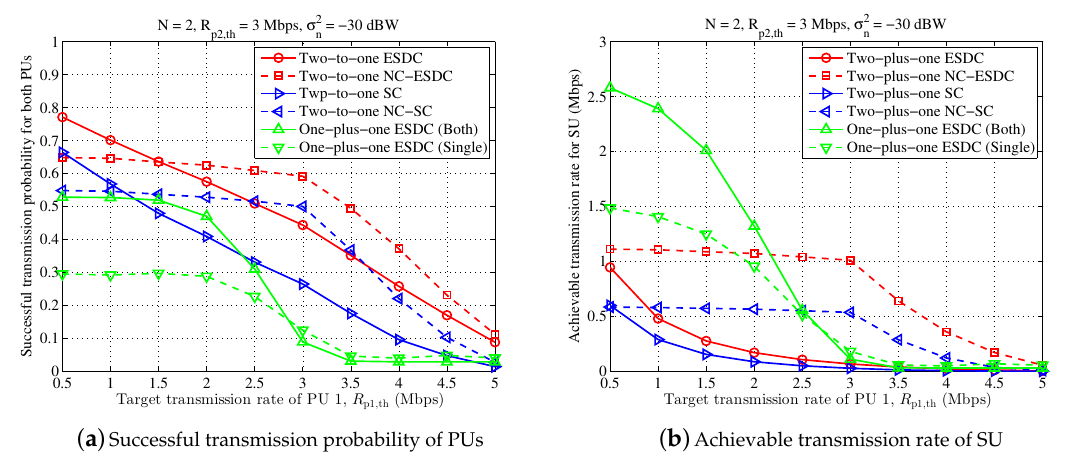
Figure 7. Performance comparison for different target transmission rates of PU 1, in which n = 2, R p2,th = 3 Mbps, σ 2 n = − 30